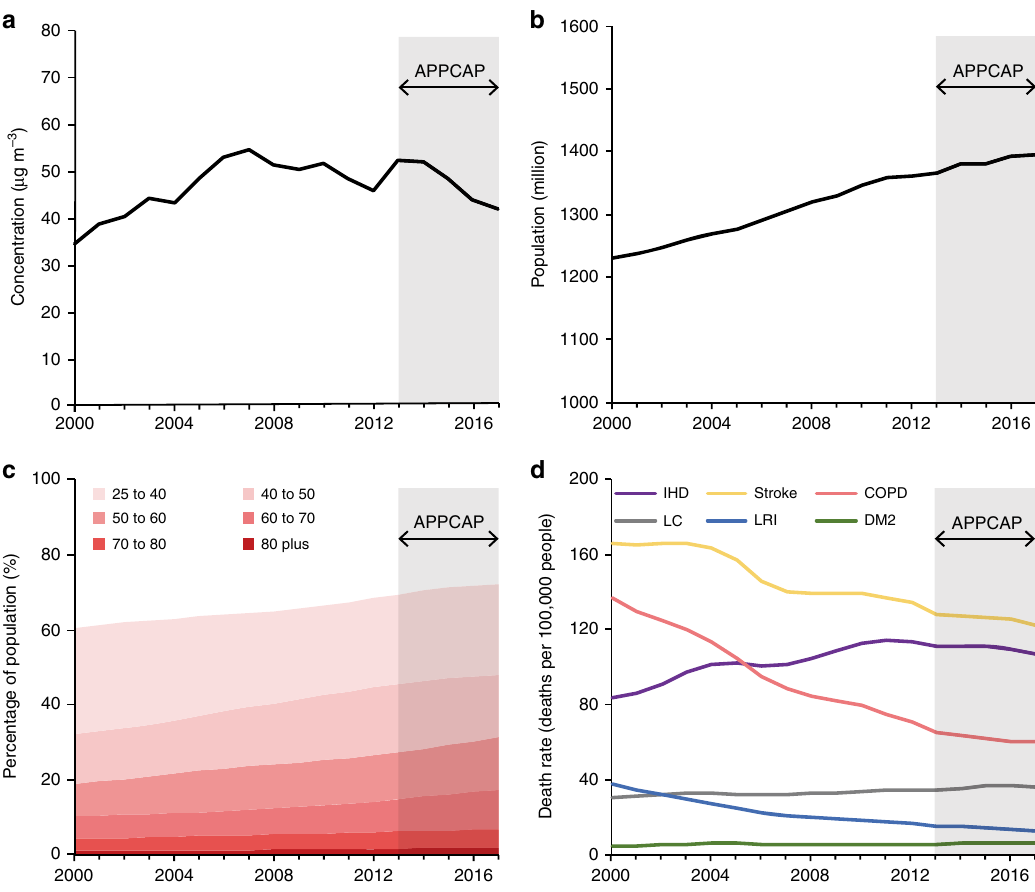
Fig. 1 Changes in the driving factors of deaths attributable to PM 2.5 pollution. a population ‐ weighted PM 2.5 concentration 59,60 . b total population 60,61 . c age structure 9 . d age ‐ standardized death rate of diseases 9 . The PM 2.5 concentration was weighted by population to indicate the overall exposure at the whole of China. IHD, COPD, LC, LRI, and DM2 refer to ischemic heart disease, chronic obstructive pulmonary disease, lung cancer, lower respiratory infection, and diabetes mellitus type 2, respectively. Source data are provided as a Source Data fi